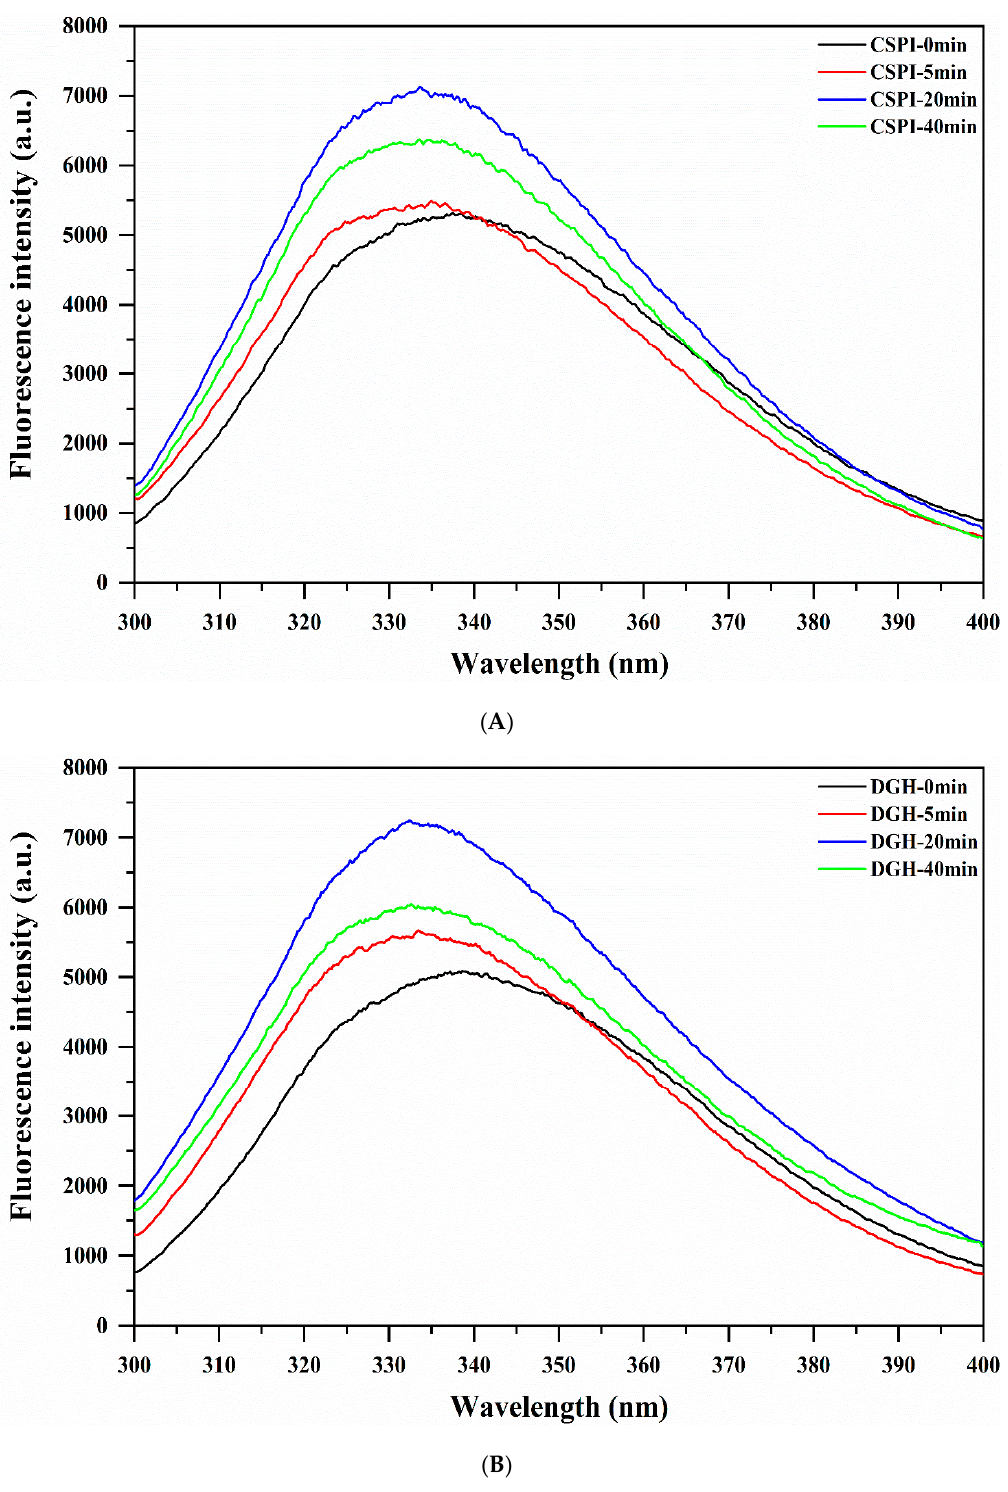
Figure 5. Effect of high-intensity ultrasound treatment (20 kHz at 400 W for 0, 5, 20, 40 min) on the intrinsic fluorescence emission spectra of CSPI ( A ) and DGH ( B ).